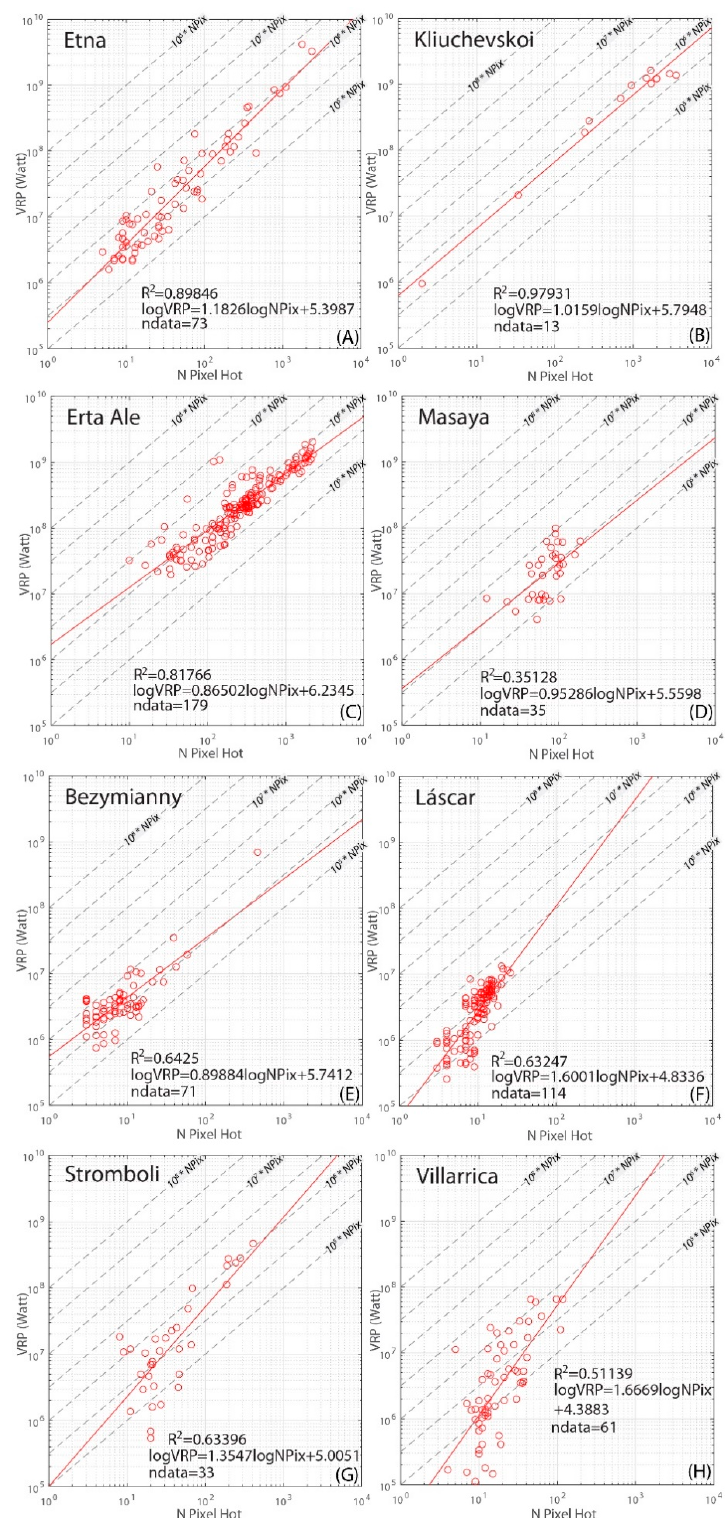
Figure 12. Log graphs for volcanic cases analyzed, ( A – H ). On y-axis, VRP (Watt); on x-axis S2Pix, the number of hot pixels. In each graph, red dots represent the closest SENTINEL-2 and MIROVA data, in an interval of ± 24 h from each S2 cloudy free acquisition; the red line represents the best fit regression for the data. R 2 values, fitting line equation and number of data are reported.